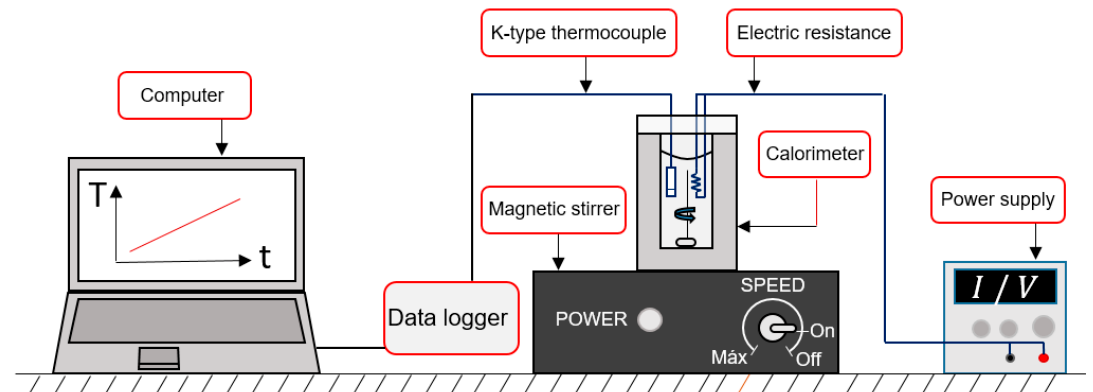
Figure 2. Measurement of heat capacity for impregnant (technical grade octadecane).